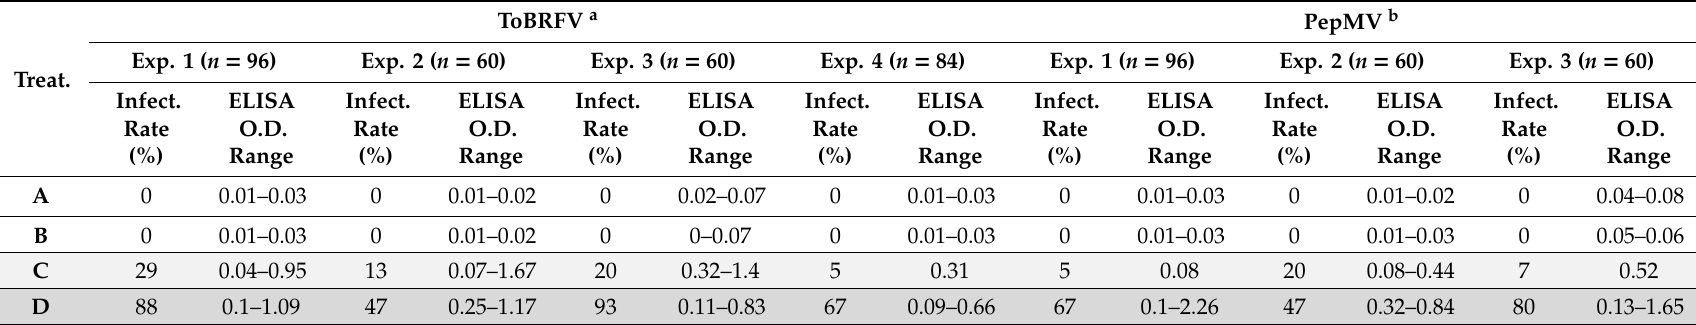
Table 2. Detection of pepino mosaic virus (PepMV) and tomato brown rugose fruit virus (ToBRFV) in leaf samples of tomato plants following four inoculation modes using enzyme linked immunosorbent assay (ELISA).